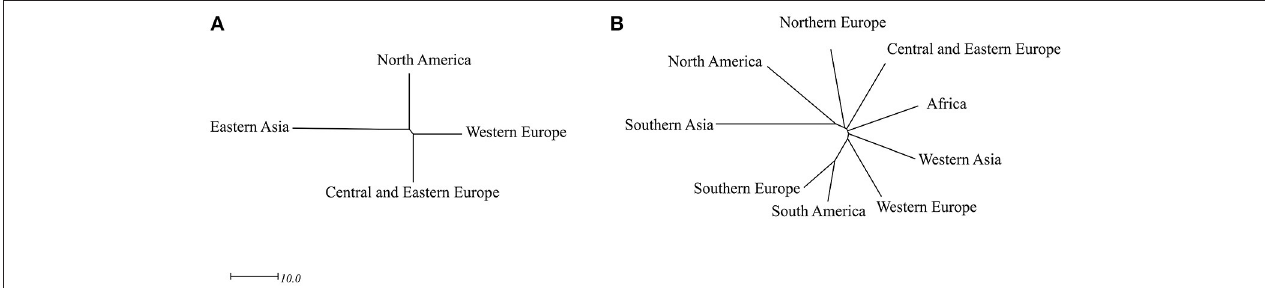
FIGURE 6 | Unrooted trees of the four major geographical origins of the 92 fiber accessions (A) and the nine major geographical origins of the 299 linseed accessions (B) . The Ward method was used to perform cluster analysis based on the Euclidean distances among the four (Table S7) and nine geographical origins (Table S8) of the two groups, respectively.